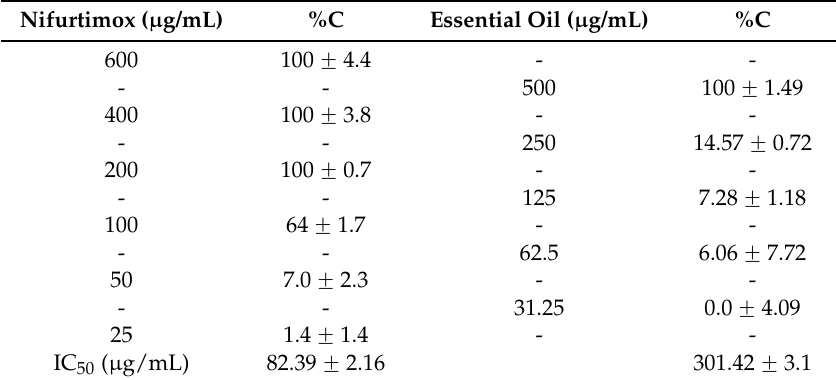
Table 4. Toxicity of Effect of L. camara leaf essential oil on NCTC929